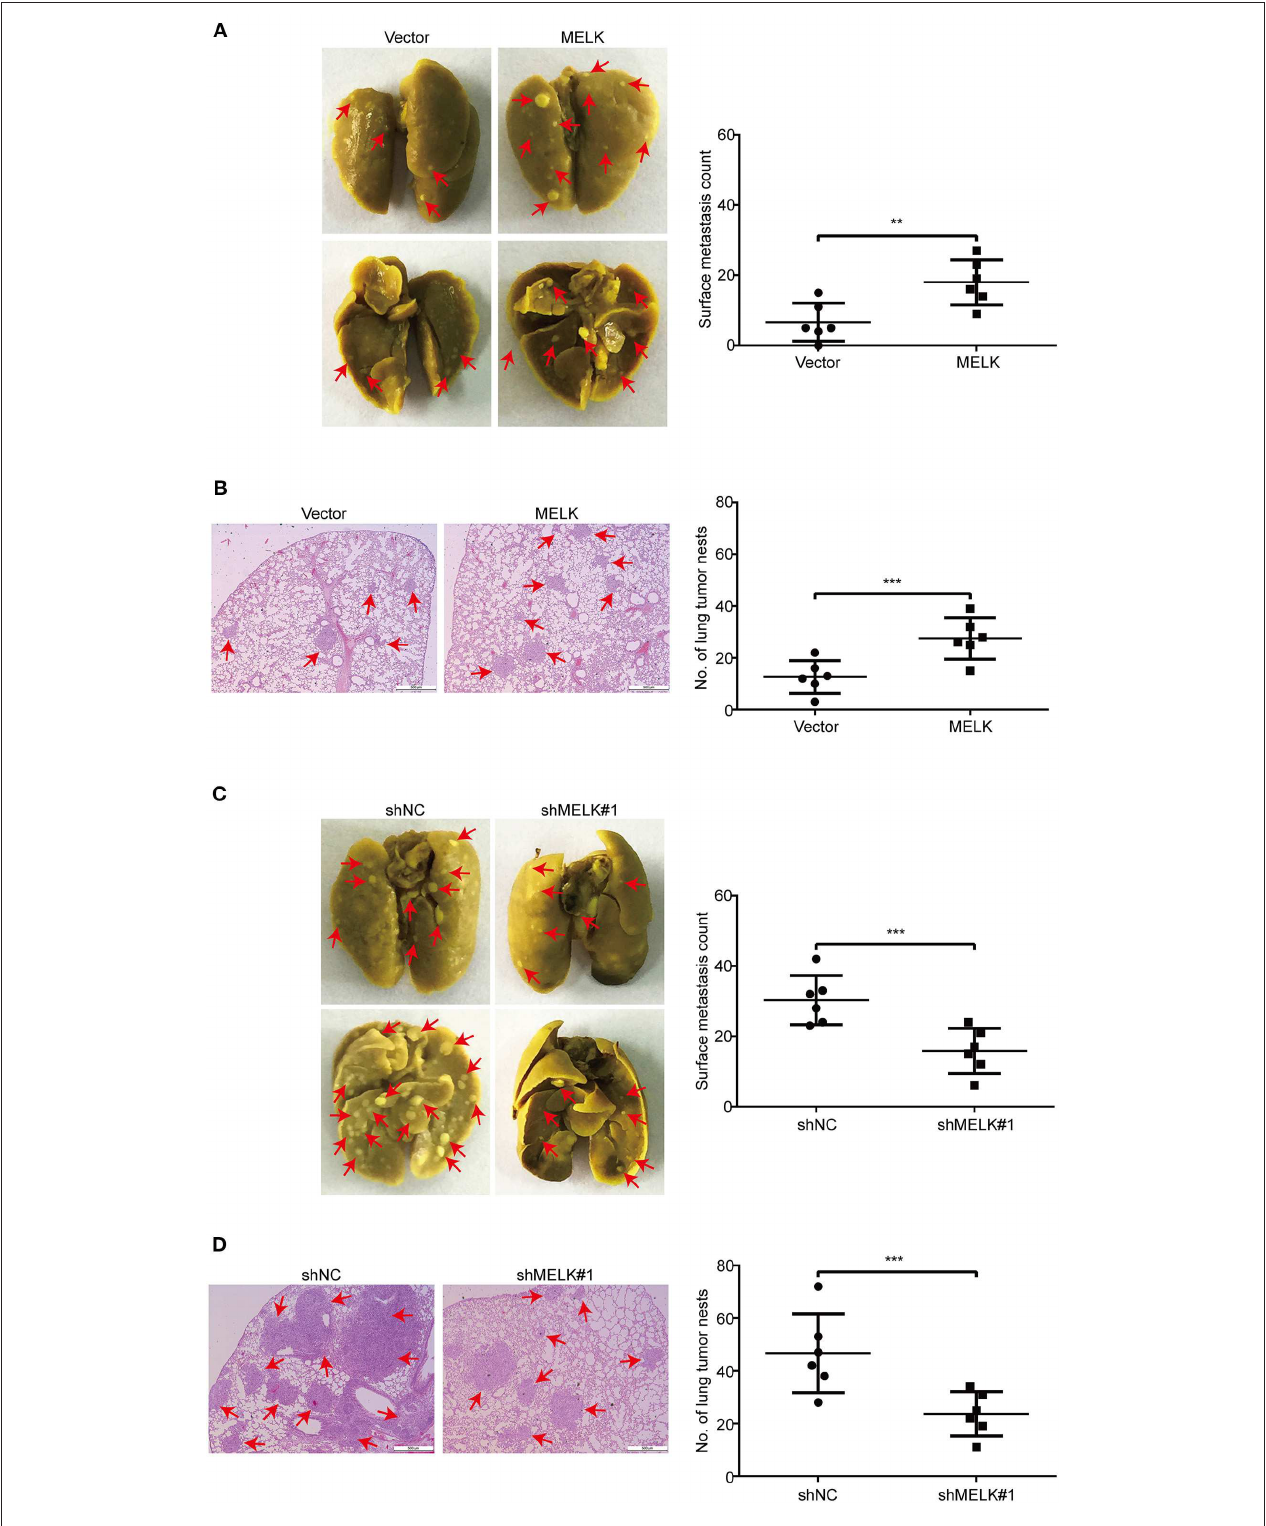
FIGURE 6 | MELK enhances ESCC cell metastasis in nude mice. (A) EC109 cells with or without MELK overexpression were intravenously injected into nude mice ( n = 6 per group) through the tail vein. (Left) Representative images of excised lungs after 8 weeks injection are shown (arrows indicate the metastatic foci). (Right) Graph showing the number of surface metastatic nodules in the lungs. (B) Lung metastases in each mice were stained with H&E. Arrows indicate the metastatic colonization of tumor cells in the lung tissues (left). The number of lung tumor nests in each group was counted (right). (C) Effects of MELK depletion on the location